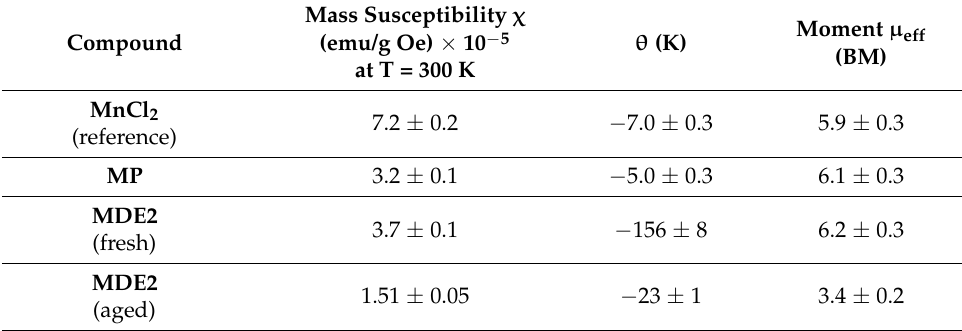
Table 1. Magnetic data of the indicated Mn